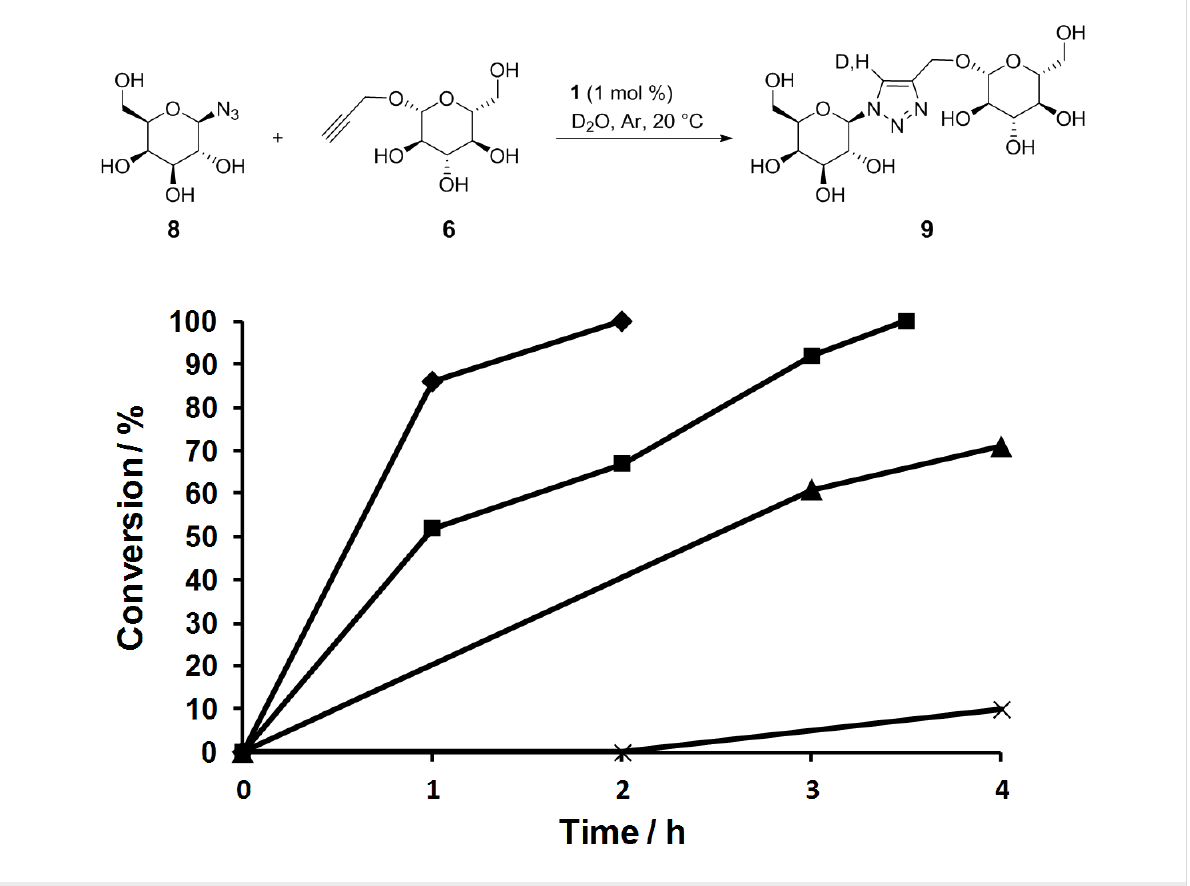
Figure 4: Reaction profiles for the formation of 9 under various illumination conditions: TLC lamp (365 nm) for 1 h, then ambient laboratory light ( ♦ ); tube in the dark (X); tube exposed to ambient laboratory light ( ▲ ); tube exposed to 23 W fluorescent bulb ( ■ ).